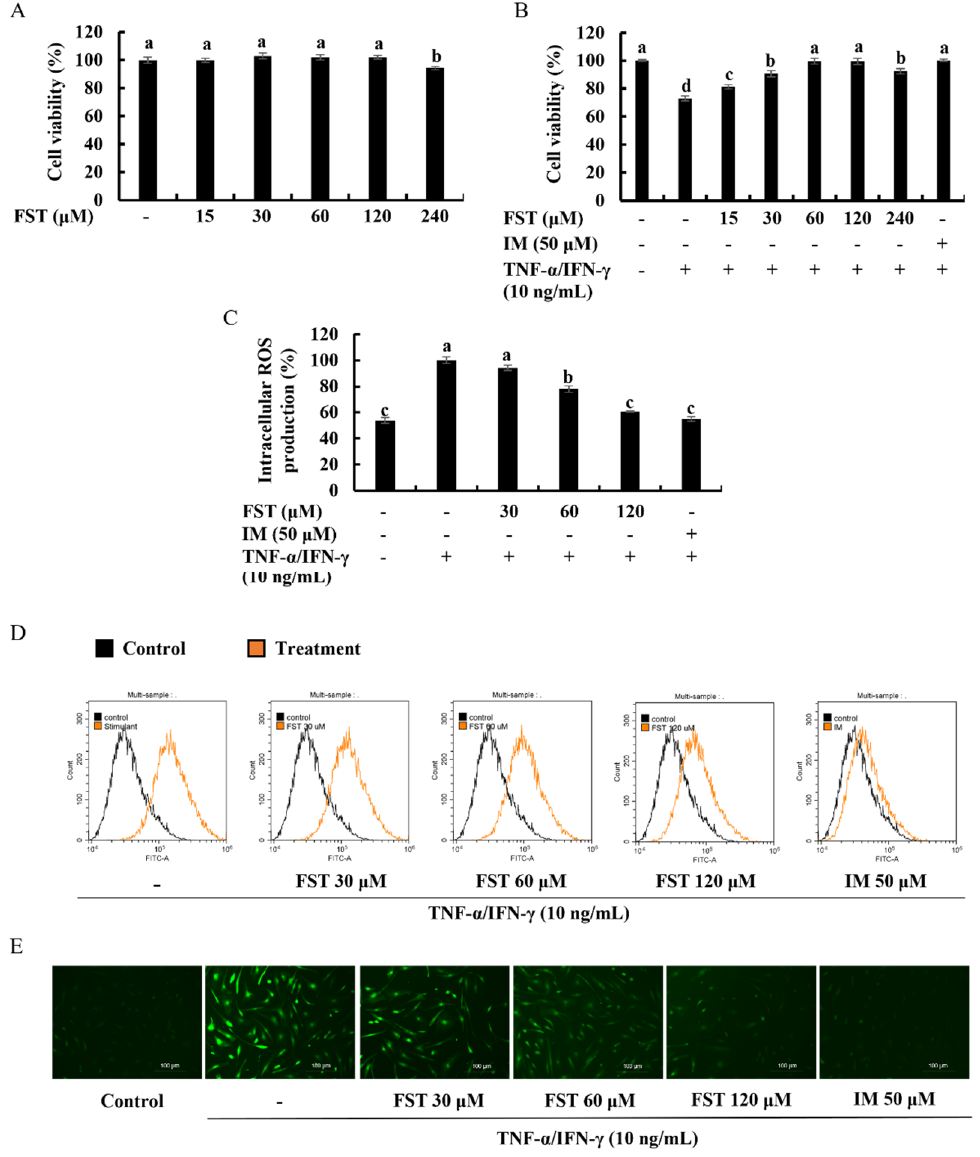
Figure 2. Cytoprotective effect of FST on human dermal fibroblasts (HDF). ( A ) Cytotoxicity, ( B ) cell viability (%), and analysis of intracellular ROS generation through ( C ) fluorometry, ( D ) flow cytometry analysis, and ( E ) fluorescence microscopy of FST-pre-treated TNF- α /IFN- γ -stimulated HDF cells. Indomethacin (IM, 50 μ M) was used as a positive control. All experiments were performed in triplicate ( n = 3) to determine the repeatability and lettered error bars were significantly different ( p < 0.05).